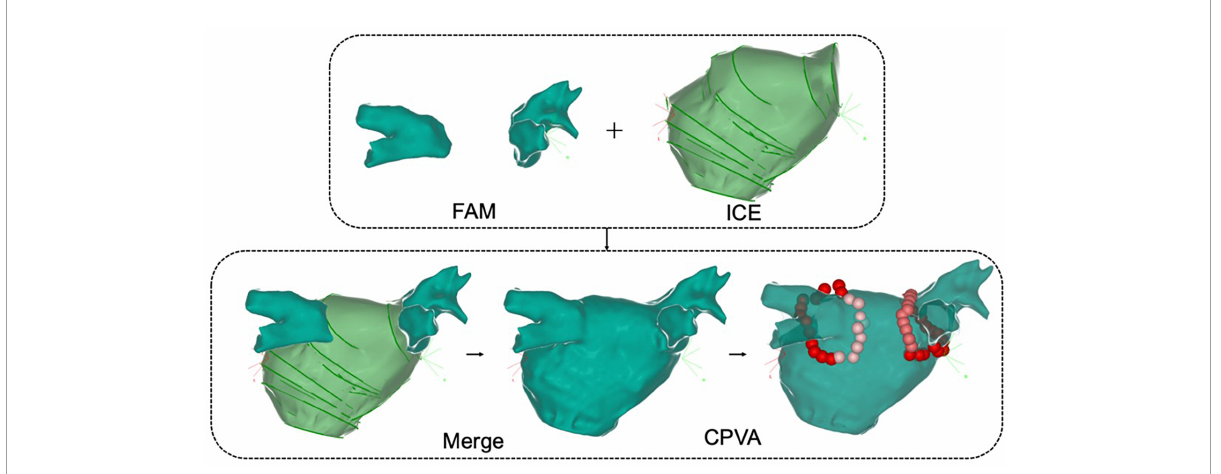
FIGURE3 Intracardiac echocardiography combined with fast anatomical reconstruction for left atrial model reconstruction. FAM, fast anatomical mapping; Merge, ICE combined with three-dimensional reconstruction; CPVA, circumferential pulmonary vein